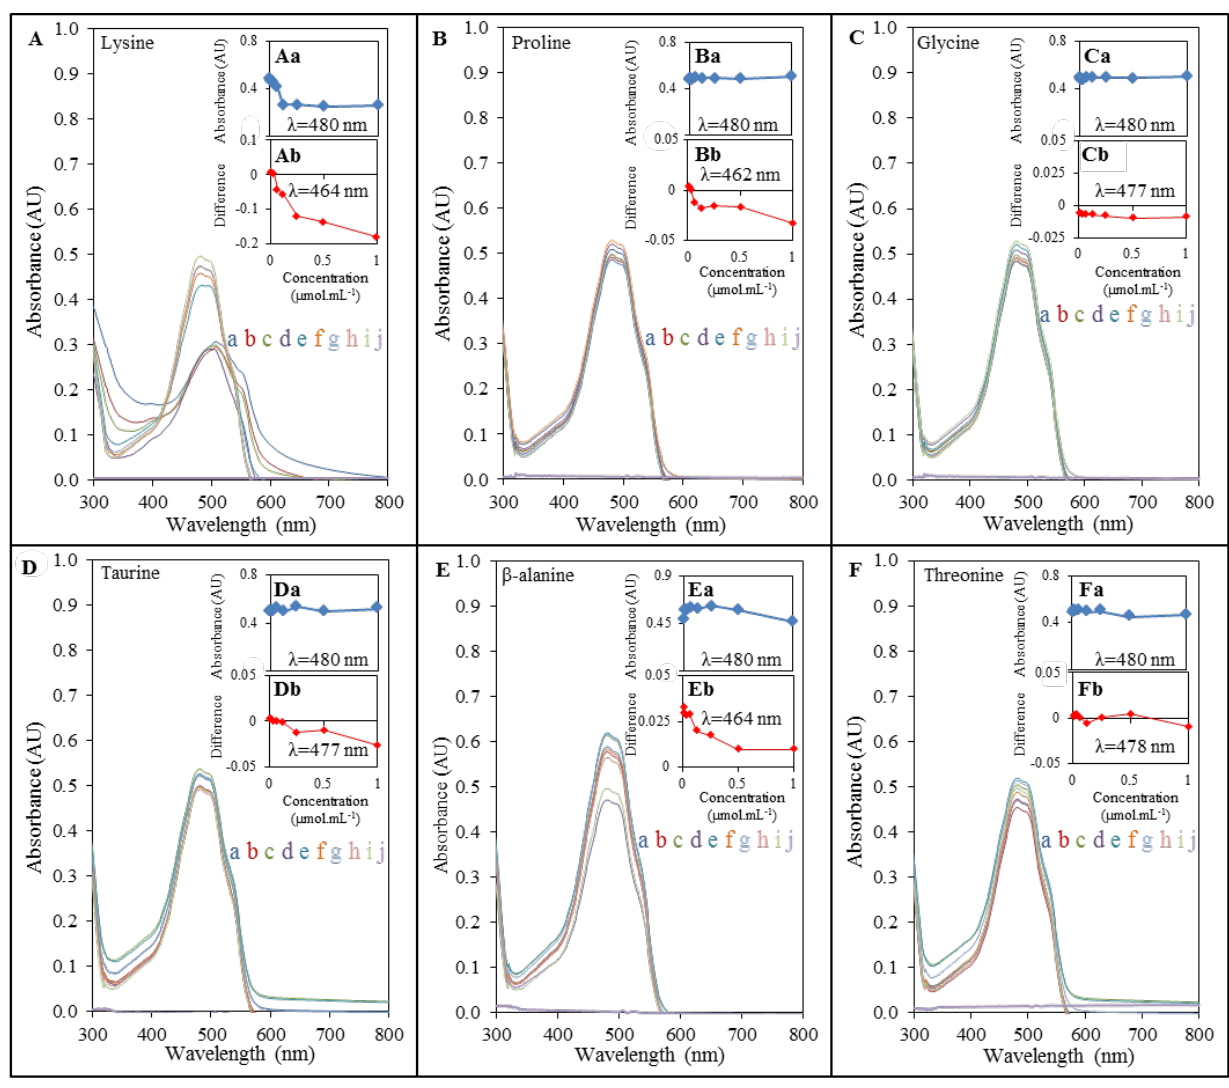
Figure 2. Interactions of amino acids (1; 2; 3; 6; 12; 25; 50; 100 µmol mL −1 ) with doxorubicin (100 µg mL −1 ) monitored with spectrophotometry. DOX interaction with: ( A ) lysine; ( B ) proline; ( C ) glycine; ( D ) taurine; ( E ) β-alanine, ( F ) threonine; where ( a ) stays for 100 µmol mL −1 ; ( b ) 50 µmol mL −1 ; ( c ) 25 µmol mL −1 ; ( d ) 12 µmol mL −1 ; ( e ) 6 µmol mL −1 ; ( f ) 3 µmol mL −1 ; ( g ) 2 µmol mL −1 ; ( h ) 1 µmol mL −1 ; ( i ) 0 µmol mL −1 and ( j ) for control (AA without DOX). The dependence of the DOX absorbance at 480 nm on the different concentrations of amino acids is shown in insets marked with lowercase letter a. Insets marked with lowercase letter b express the differences obtained from differential spectra gained as a readout of DOX spectrum from DOX-AA complex spectrum with observed wavelength maximum